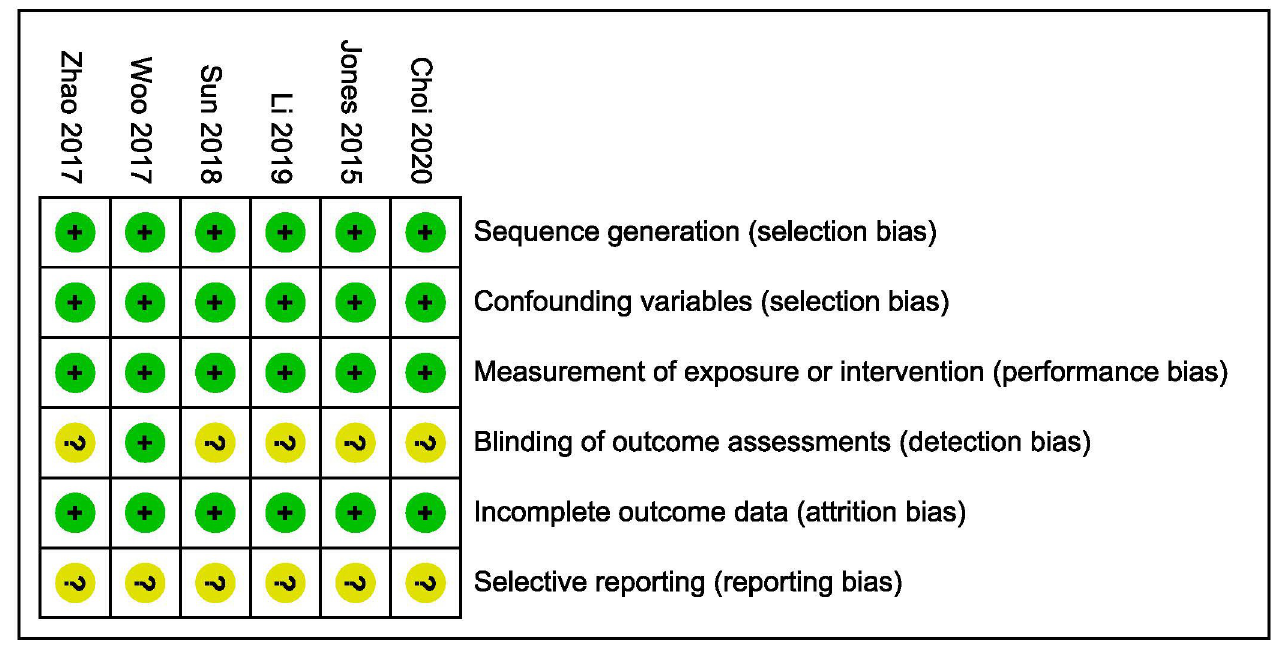
Fig 3. The methodological quality for non-randomized comparative studies.